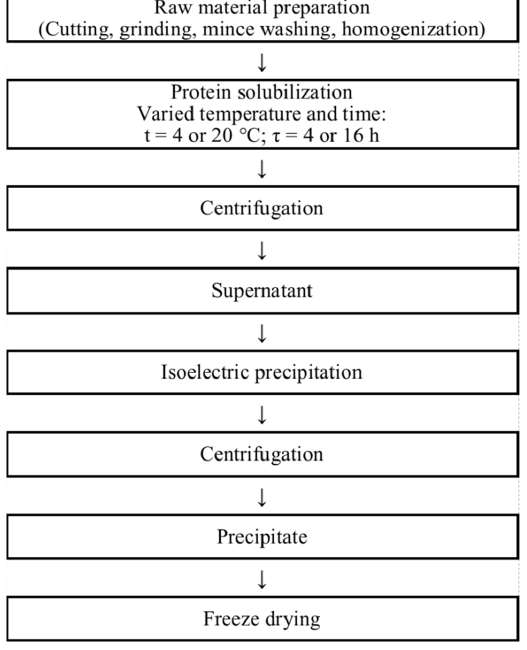
Figure 7. Technological scheme for obtaining protein isolate.